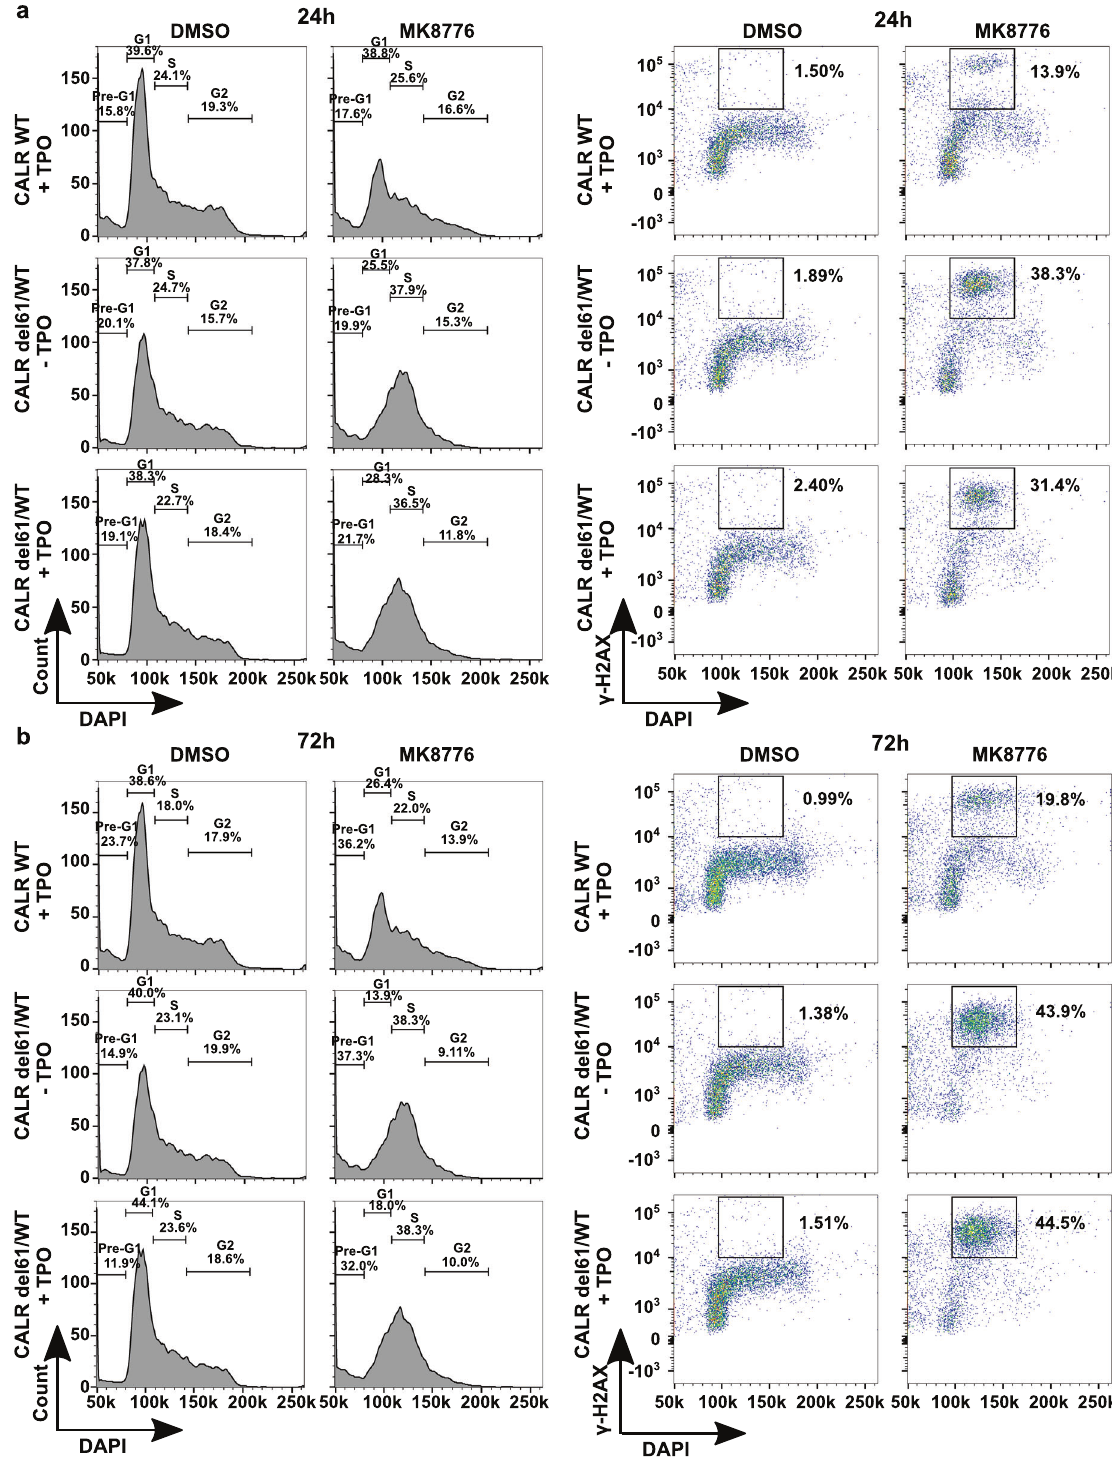
Fig. 4 CHK1 inhibitors induce S-phase cell cycle arrest in CALR mutated cells. a Left panel: histogram of UT-7/Tpo CALR WT and CALR del61/ WT cell lines treated with 1 µM MK8776 or DMSO for 24 h, followed by DAPI staining to indicate DNA content. The percentage of cells at pre- G1, G1, S, G2-M phases is labeled in the graphs. Right panel: FACS co-staining of DAPI and γ -H2AX at a 24 h time point post-treatment. γ -H2AX positive S-phase cells are labeled and the percentage of this population is indicated in the graphs. b Left panel: histogram of UT-7/Tpo CALR WT and CALR del61/WT cell lines treated with 1 µM MK8776 or DMSO for 72 h, followed by DAPI staining to indicate DNA content. The percentage of cells at pre-G1, G1, S, G2-M phases is labeled in the graphs. Right panel: FACS co-staining of DAPI and γ -H2AX at a 72 h time point post-treatment. γ -H2AX positive S-phase cells are labeled and the percentage of this population is indicated in the graphs.